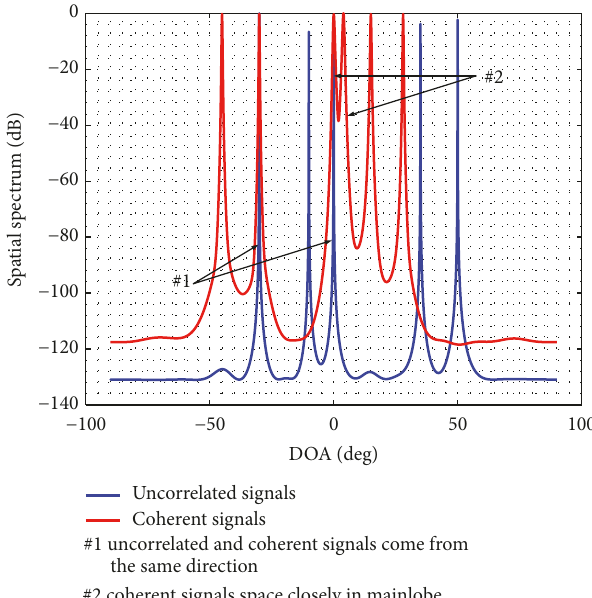
Figure 2: Spatial spectrums of the uncorrelated and coherent